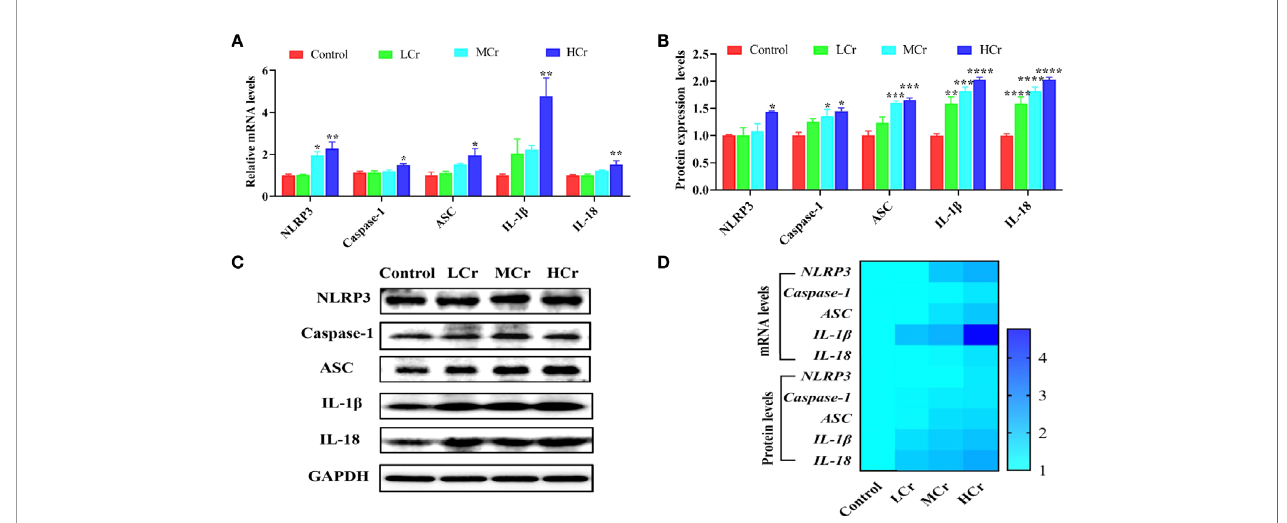
FIGURE 5 | Effects of Cr(VI) exposure on NLRP3 in fl ammasome activation in jejunum tissues. (A) Pyroptosis-related gene mRNA levels. (B) Quantitative analysis of pyroptosis-related factor protein levels. (C) Western blot demonstrates pyroptosis-related protein expression. (D) A heatmap depicts the relationship between the expression of pyroptosis-related genes and proteins in jejunum tissues. The symbol “ * ” denotes a statistically signi fi cant difference from the control group (* P < 0.05, ** P < 0.01, *** P < 0.005 and **** P < 0.001).